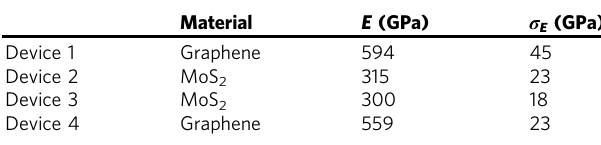
Table 2 Summary of extracted Young ’ s moduli and corresponding errors ( σ E ) of the different samples measured in this work